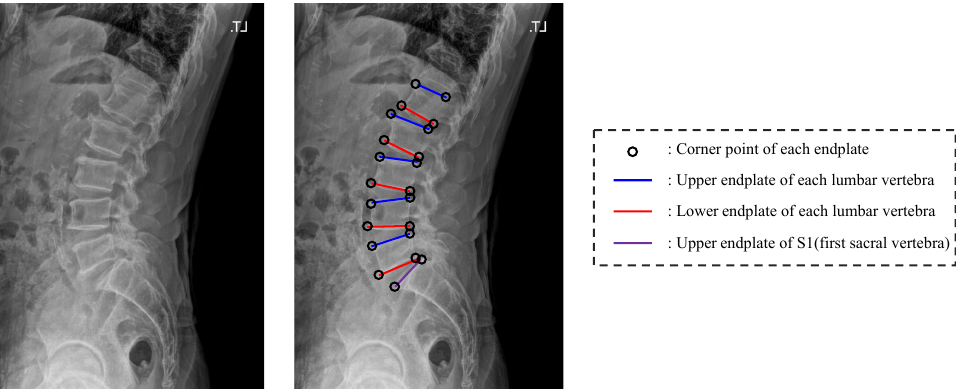
Figure 1. Illustration for the corner point and upper and lower end plate of each